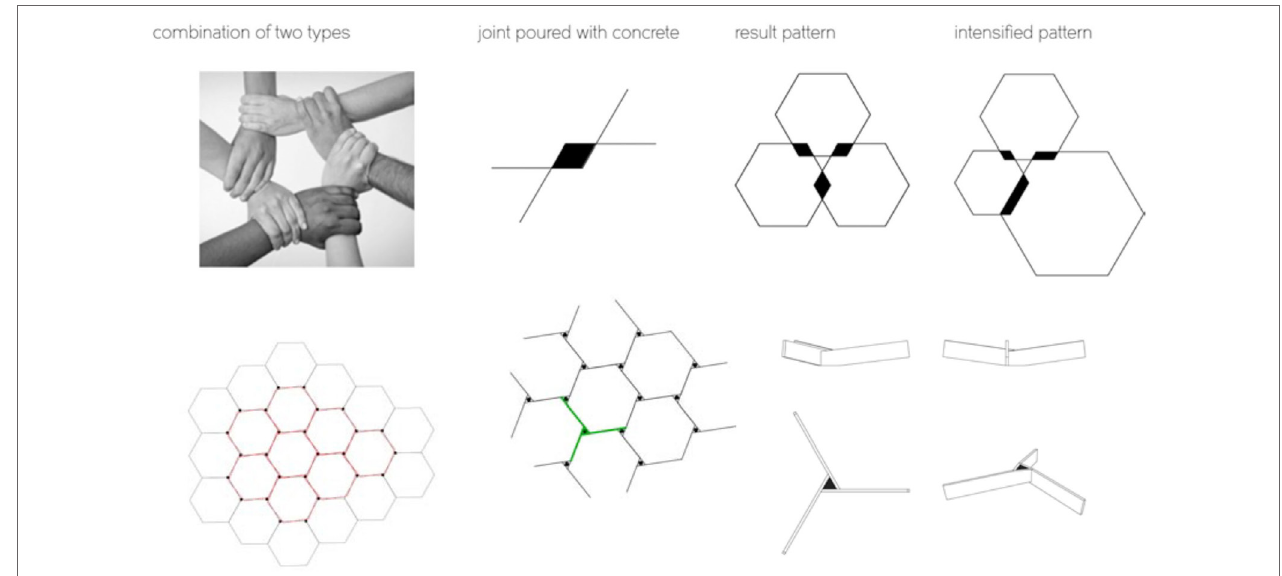
FIgURe 4 | Nodes and concrete casting